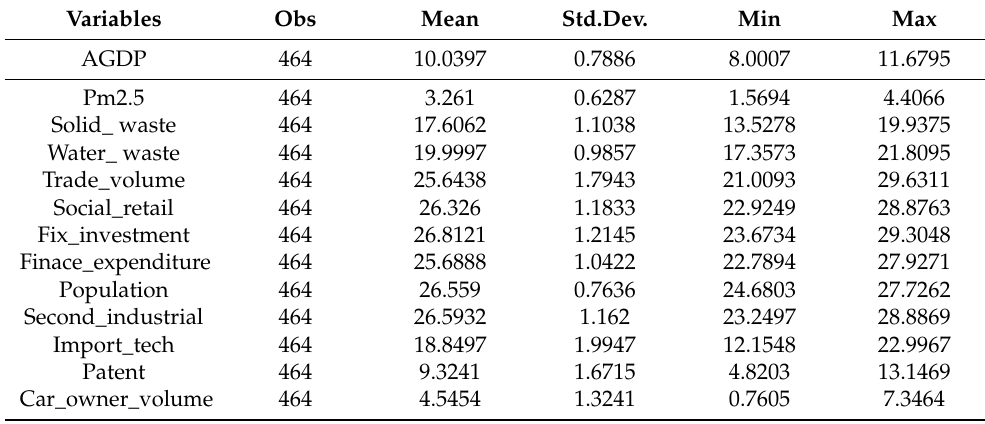
Table A1. Description statistics of the